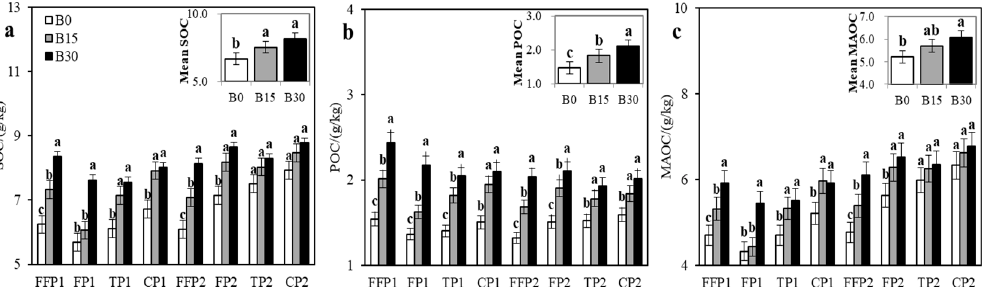
Figure 2. Different fractions of annual SOC in response to biochar addition. (Note: Different lowercase represents significant difference at p < 0.05 between treatments).